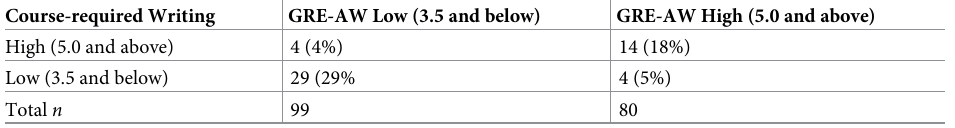
Table 7. Percent of students with relatively high or low scores on course-required writing by GRE-AW score categories. Course-required Writing GRE-AW Low (3.5 and below) GRE-AW High (5.0 and